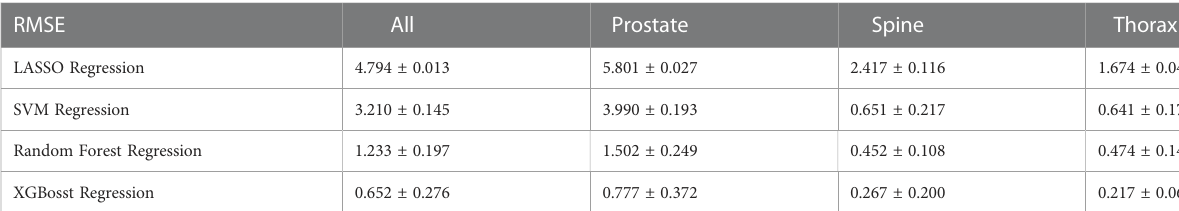
TABLE 3 RMSE values across all 10-fold for each model. RMSE